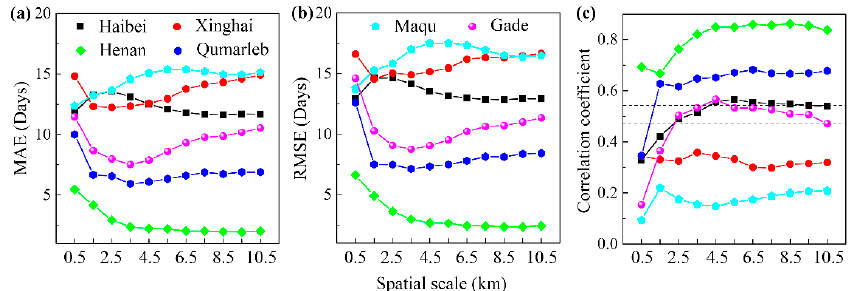
Figure A1. The evaluation of MODIS land surface green-up onset. MAE ( a ), RMSE ( b ) and correlation coefficient ( c ) between multi-species mean green-up date and NDVI retrieved median green-up onset within different window sizes from 2000 to 2012. X -axis is the window size from 0.5 to 10.5 km. Y -axis is the MAE (days), RMSE (days) and correlation coefficient, respectively. Values above the high and low dashed lines in ( c ) denote significantly positive correlation at p < 0.05 and p < 0.1 levels, respectively. The symbols with different shapes and colors represent different phenological stations.